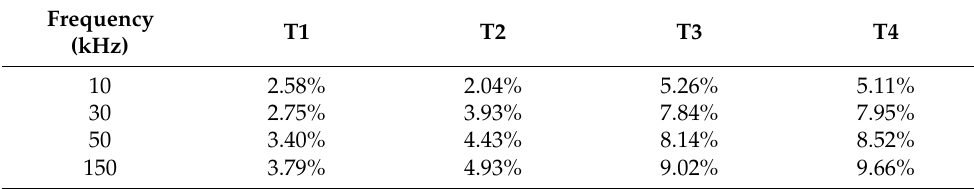
Table 5. The increase rate of attenuation rate η .